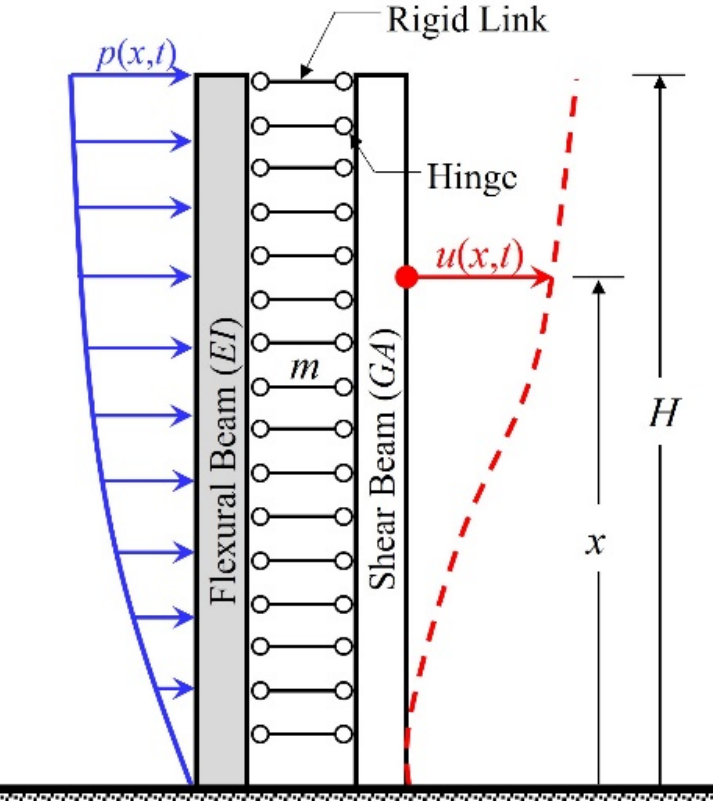
Figure 1. Definitions and properties of CSFCBM.